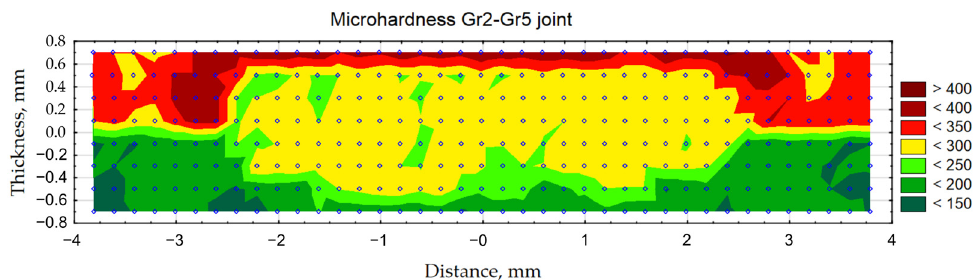
Figure 14. Contour map of the microhardness of the Gr2–Gr5 joint weld.